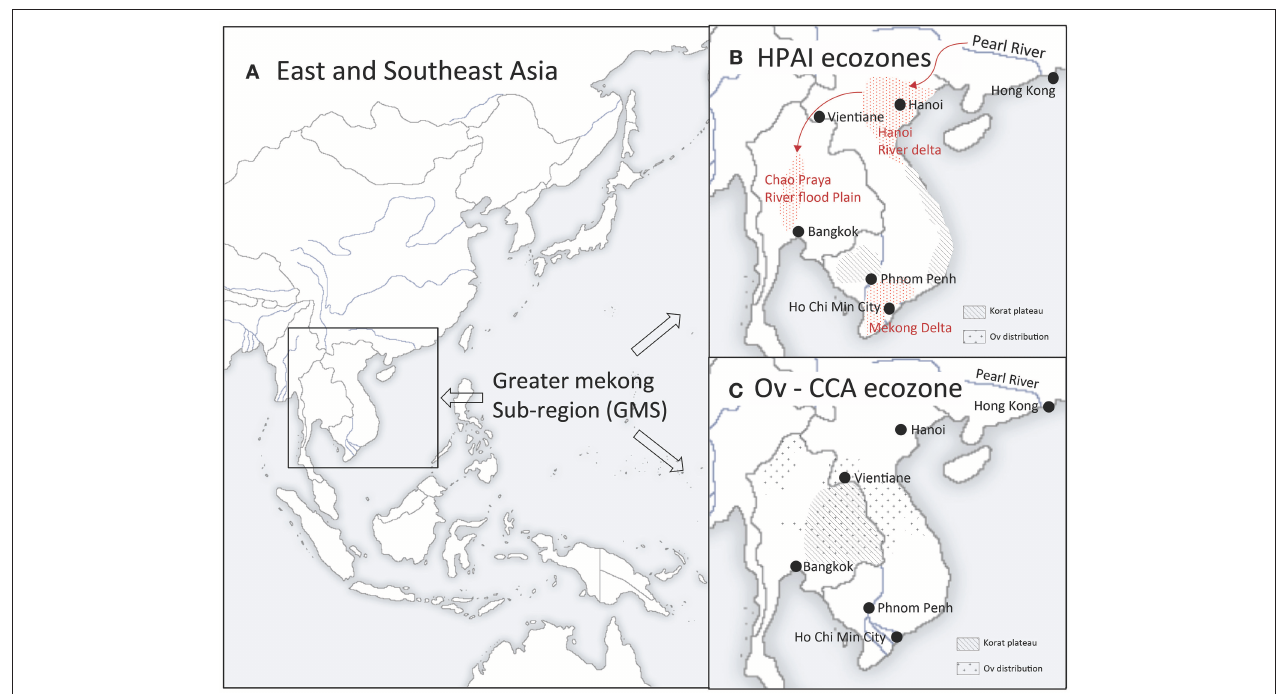
FIGURE 3 | Greater Mekong Subregion and ecozones of the case examples. (A) East and Southeast Asia. The Greater Mekong Subregion includes six nations (Cambodia, China, Laos, Myanmar, Thailand, and Vietnam) whose national boundaires overlap the hydrographic boundaries of the Mekong River Basin. (B) HPAI ecozones. Red stippled areas indicate the distribution of Highly Pathogen Avian Influenza (H5N1) cases during the 2003-4 emergence/pandemic. These three perennial flood zones of Thailand (Chao Praya River flood plain) and Vietnam (Red River and Mekong Deltas) are centers of concentration of domestic poultry production as well of wild water birds including the primary natural host reservoirs for avian influenza viruses, dabbling ducks. Chickens and domesticated duck production, trade networks, and wet markets grew explosively beginning in the 1980’s in response to increased export market demand. This represented a social-ecological system transformation and ultimately a regime shift from once the first H5N1 virus variant invaded Vietnam’s Red River Delta from the Pearl River Basin or elsewhere in China. The Red River Delta may have provide the key stepping stone to southern Vietnam’s Mekong Delta and Thailand’s Chao Prya River Basin. Following these first epidemic waves outbreaks were brought under control in the Chao Prya, but not in Vietnam where HPAI outbreaks continue to occur. (C) Liver fluke-Liver Cancer ecozones. Opisthorchis viverrini infection in humans is wide-spread throughout its geographic distribution. Yet its epidemiological characteristics in the Korat Plateau are distinct, reflecting its unique culture and environment. The Plateau historically had been sparsely populated (by human’s and likely the liver fluke as well) but grew exponentially since WWII while dams and irrigation systems transformed the Plateau’s social-ecology including expanding favorable aquatic habitat for Bythnia snails, O. viverrini’ s first intermediate host. The Plateau’s population ( ∼ 25 million people today) of predominantly Lao dialect-speaking, a rice-fish culture for the second intermediate host, is a staple food. As is observed when they relocate today within Thailand, along with this food cultural practice, they would have carried the fluke with them from their area of origin in Southern China as they migrated southward during the last